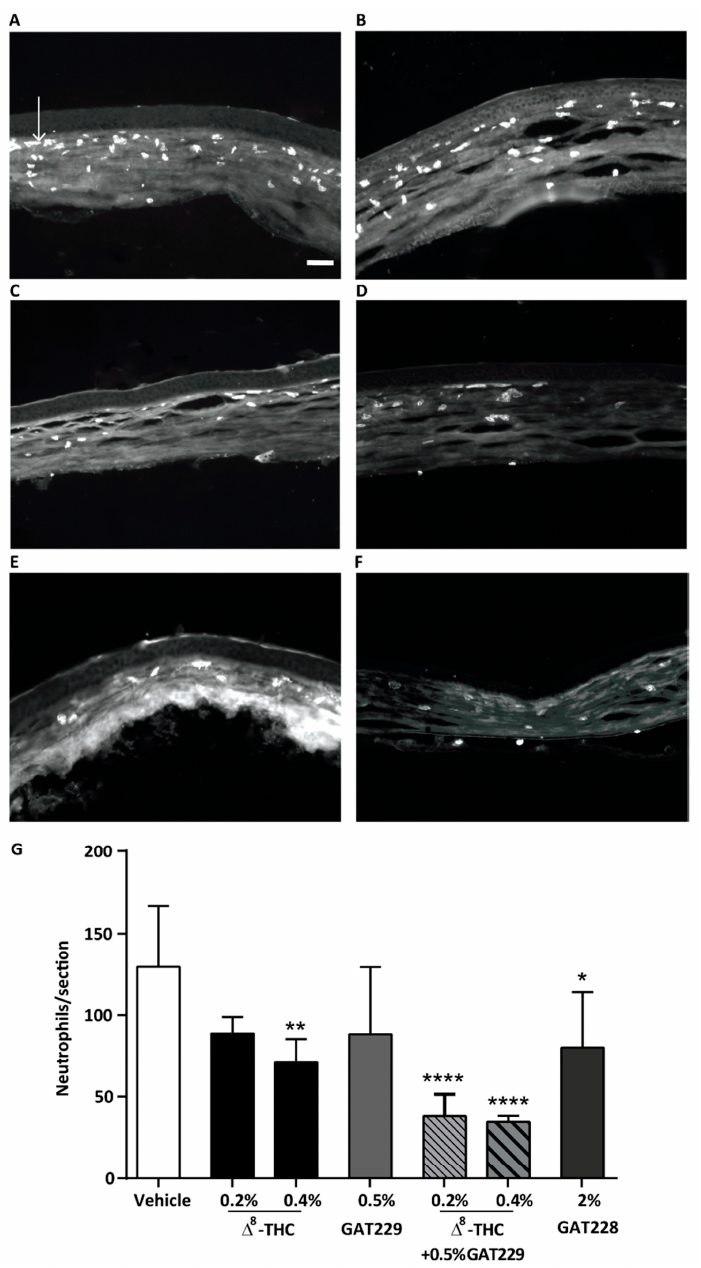
Figure 6 . Δ 8-THC exerted antinociceptive and anti-inflammatory effects after topical administration in a hyperalgesia mouse model. The figure shows neutrophil expression in cauterized corneas at 6 h post-injury following the topical treatments of drug or vehicles and capsaicin stimulation. Representative images of transverse sections of the central cornea from ( A ) vehicle-treated corneas, ( B ) 0.2% Δ 8-THC-treated corneas, ( C ) 0.5% GAT229-treated corneas, ( D ) 2% GAT228-treated corneas, ( E ) 0.2% Δ 8-THC + 0.5% GAT229 and ( F ) 0.4% Δ 8-THC + 0.5% GAT229. ( G ) Effects of topical treatment of WT-cauterized eyes with (0.2 and 0.4%) Δ 8-THC, 0.5% GAT229, 2% GAT228 or 0.2% or 0.4% Δ 8-THC + 0.5% GAT229 (n = 4–6 per group) in neutrophil infiltration compared to vehicle-treated eyes (n = 7). GAT211 CB1: allosteric ligand; GAT228 and GAT229: GAT211 enantiomers. Values represent the means ± SD. Arrow in ( A ) points to one of many infiltrating neutrophils. Scale bar: 50 µ m. For statistical analysis one-way ANOVA with Dunnett’s post hoc test (compared to the vehicle) was used. * p < 0.05, ** p < 0.01, **** p < 0.0001. Reproduced from Thapa et al.